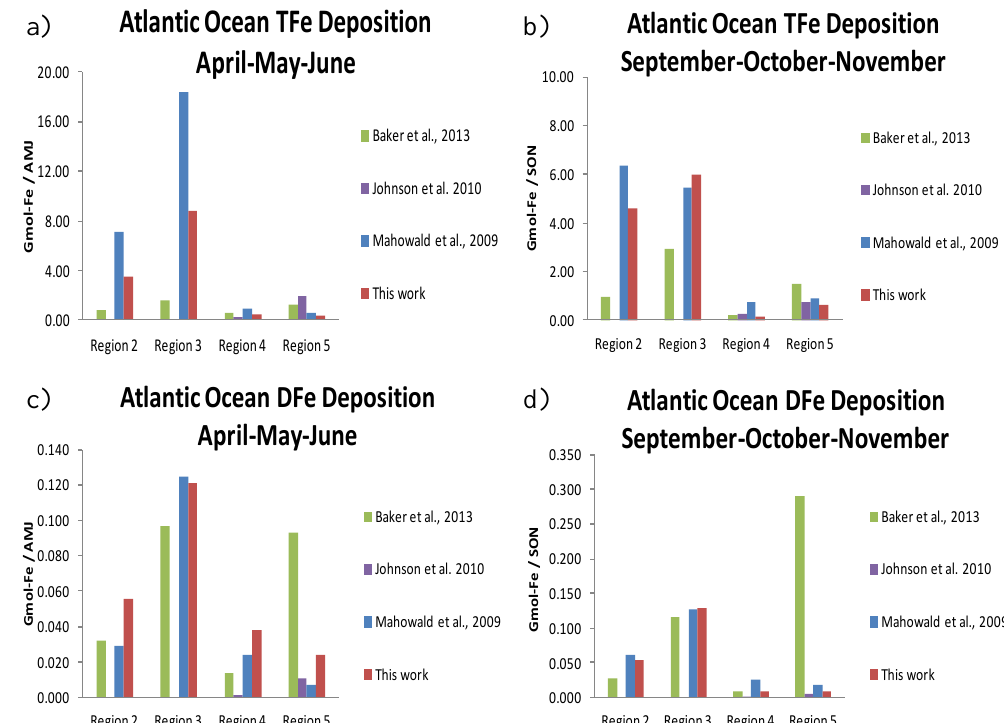
Figure 7. Comparison of total Fe (TFe) and dissolved-Fe (DFe) input estimates to four Atlantic Ocean regions during the April–May–June (AMJ; a, c ) and September-October-November (SON; b, d ) periods (in Gmol-Fe), as compiled by Baker et al. (2013).